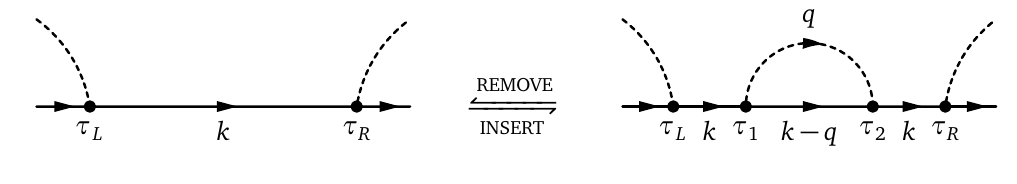
Figure 6: Illustration of the INSERT-REMOVE pair of